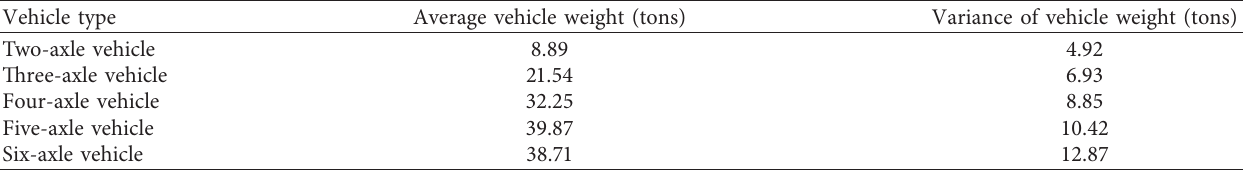
Table 2: Statistical characteristics of the vehicle weight.